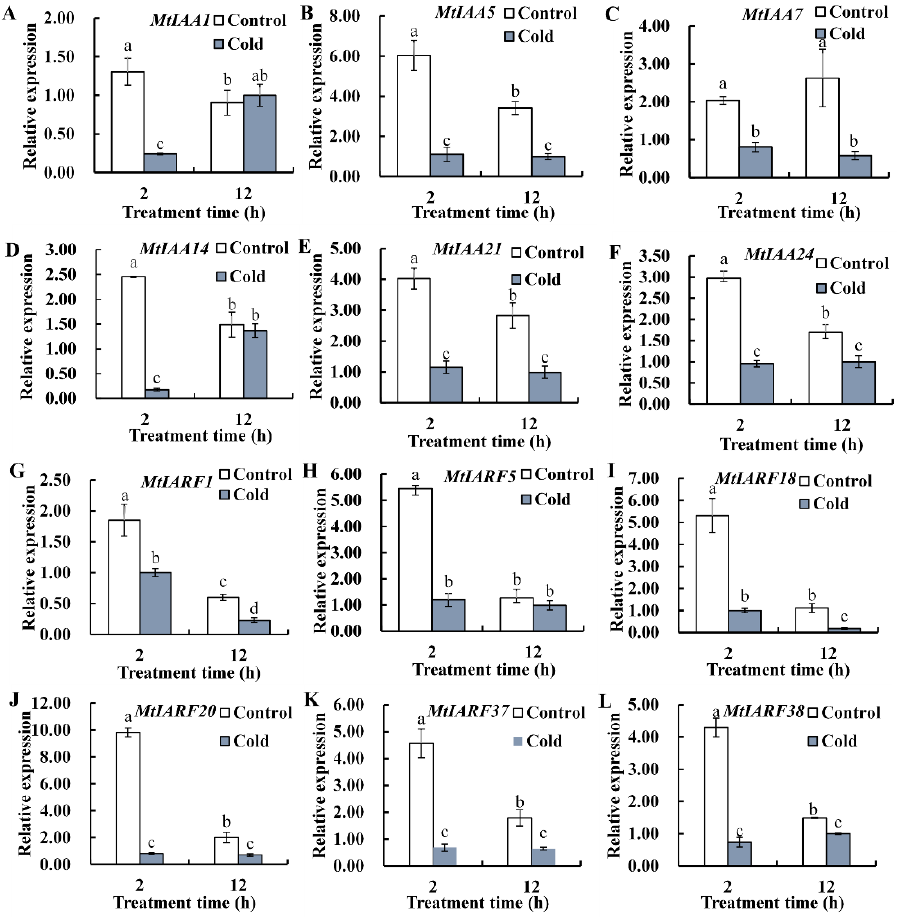
Figure 7. Relative expression of MtIAA1 ( A ), MtIAA5 ( B ), MtIAA7 ( C ), MtIAA14 ( D ), MtIAA21 ( E ), MtIAA24 ( F ), MtARF1 ( G ), MtARF5 ( H ), MtARF18 ( I ), MtARF20 ( J ), MtARF37 ( K ) and MtARF38 ( L ) in response to cold. The presented are means and standard errors of three independent experiments. The different letters in a column denote significant differences among the treatments at p <